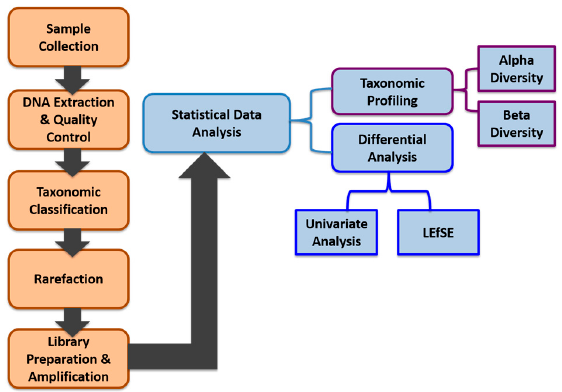
Figure 1. Workflow for the salivary microbiome data generation, pre-processing, and analysis.